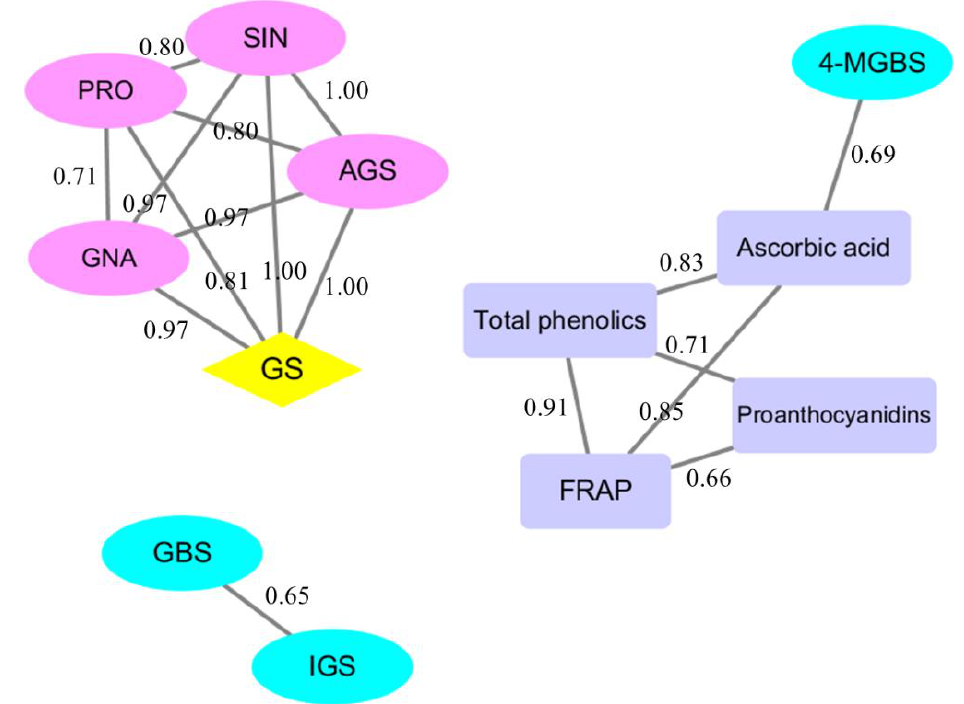
Figure 5. Correlation plot of the correlations between health-promoting phytochemicals and antioxi- dant capacity in mustard sprouts. All correlations in the figure reflect the absolute values of Pearson correlation coefficient above the threshold (R 2 > 0.65). The numbers on the lines represent the specific value of the correlation coefficient. SIN: sinigrin; GNA: gluconapin; PRO: progoitrin; NGBS: neogluco- brassicin; GBS: glucobrassicin; 4-MGBS: 4-methoxyglucobrassicin; 4-HGBS: 4-hydroxyglucobrassicin; AGS: total aliphatic glucosinolates; IGS: total indolic glucosinolates; GS: total glucosinolates.